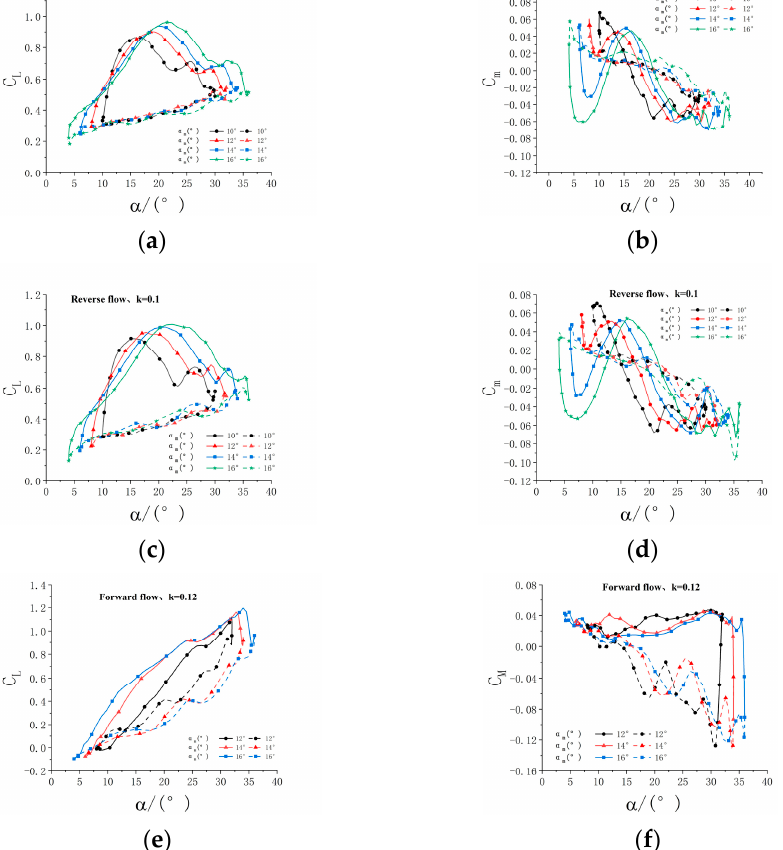
Figure 16. Effect of the oscillation amplitude at different reduced frequencies. ( a ) K = 0.08, C L , ( b ) K = 0.08, C m , ( c ) K = 0.10, C L , ( d ) K = 0.10, C m , ( e ) K = 0.12, C L , ( f ) K = 0.12, C m .